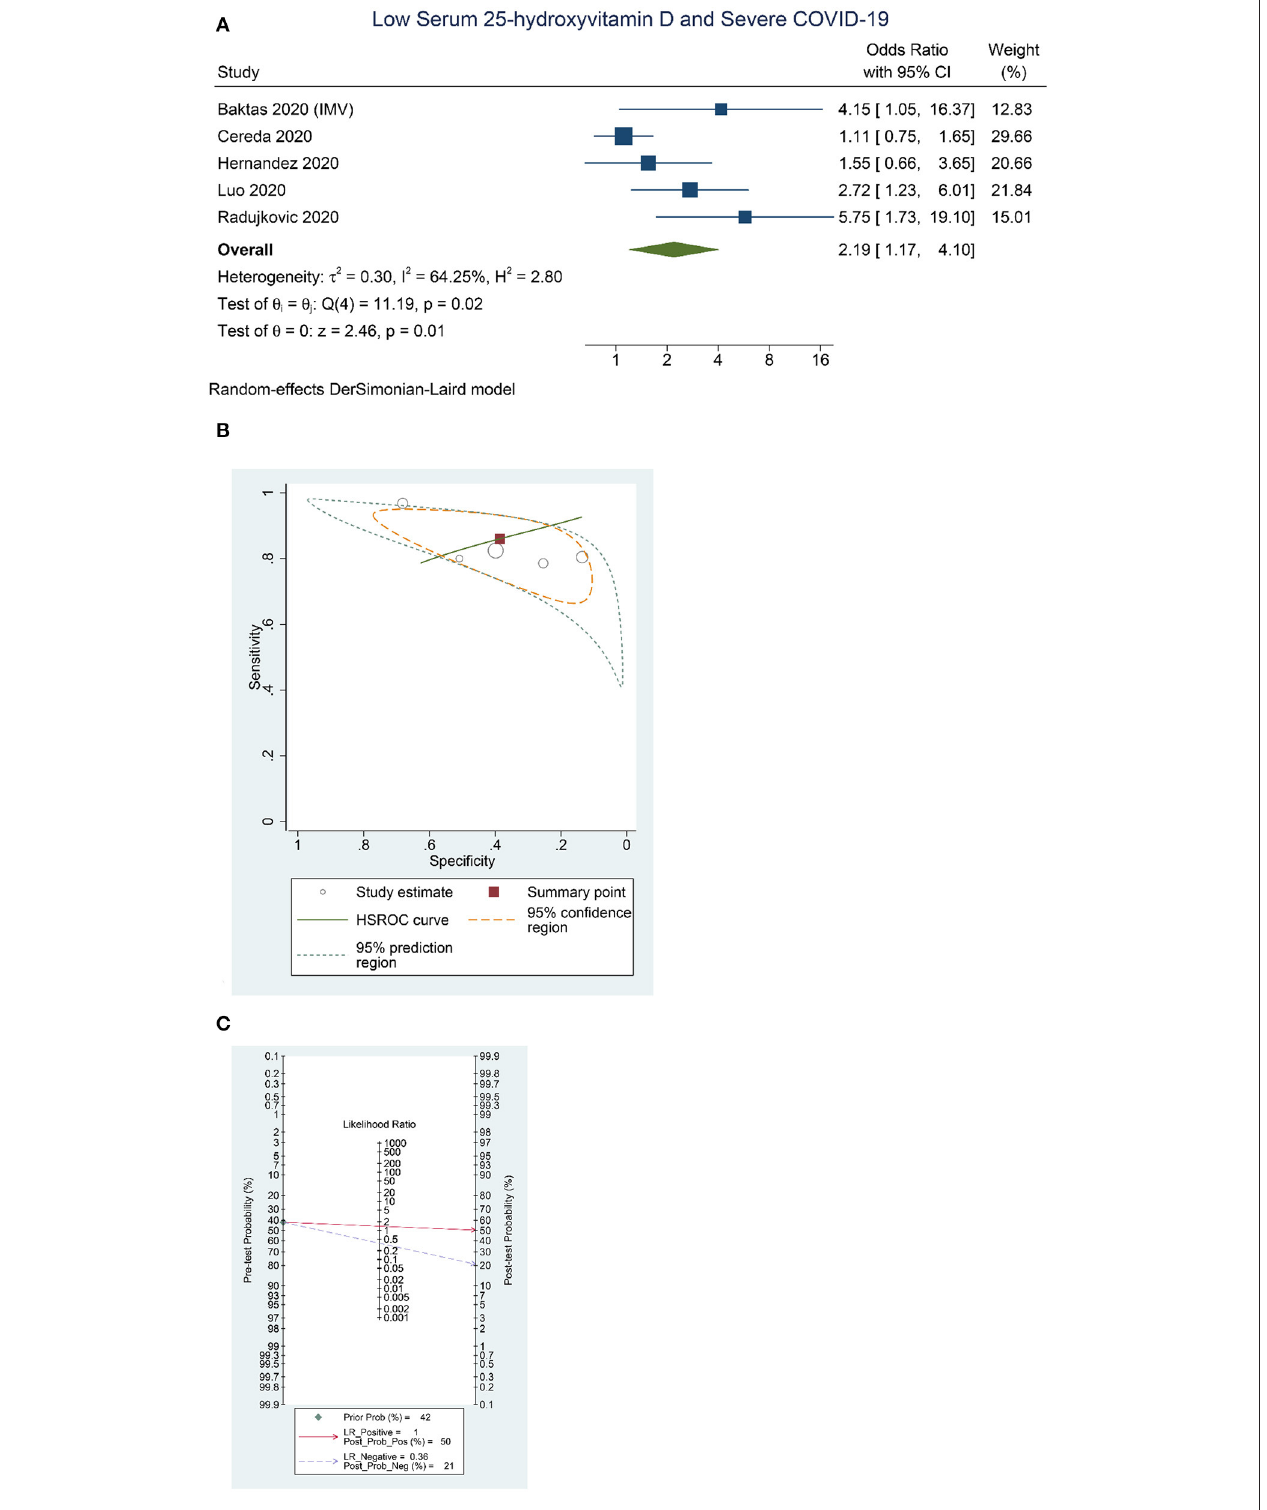
FIGURE 3 | Low Serum 25-hydroxyvitamin D and Severe COVID-19. Forest-plot (A) , HSROC curve (B) , and Fagan’s Nomogram (C) . HSROC, hierarchical summary receiver operating characteristic.